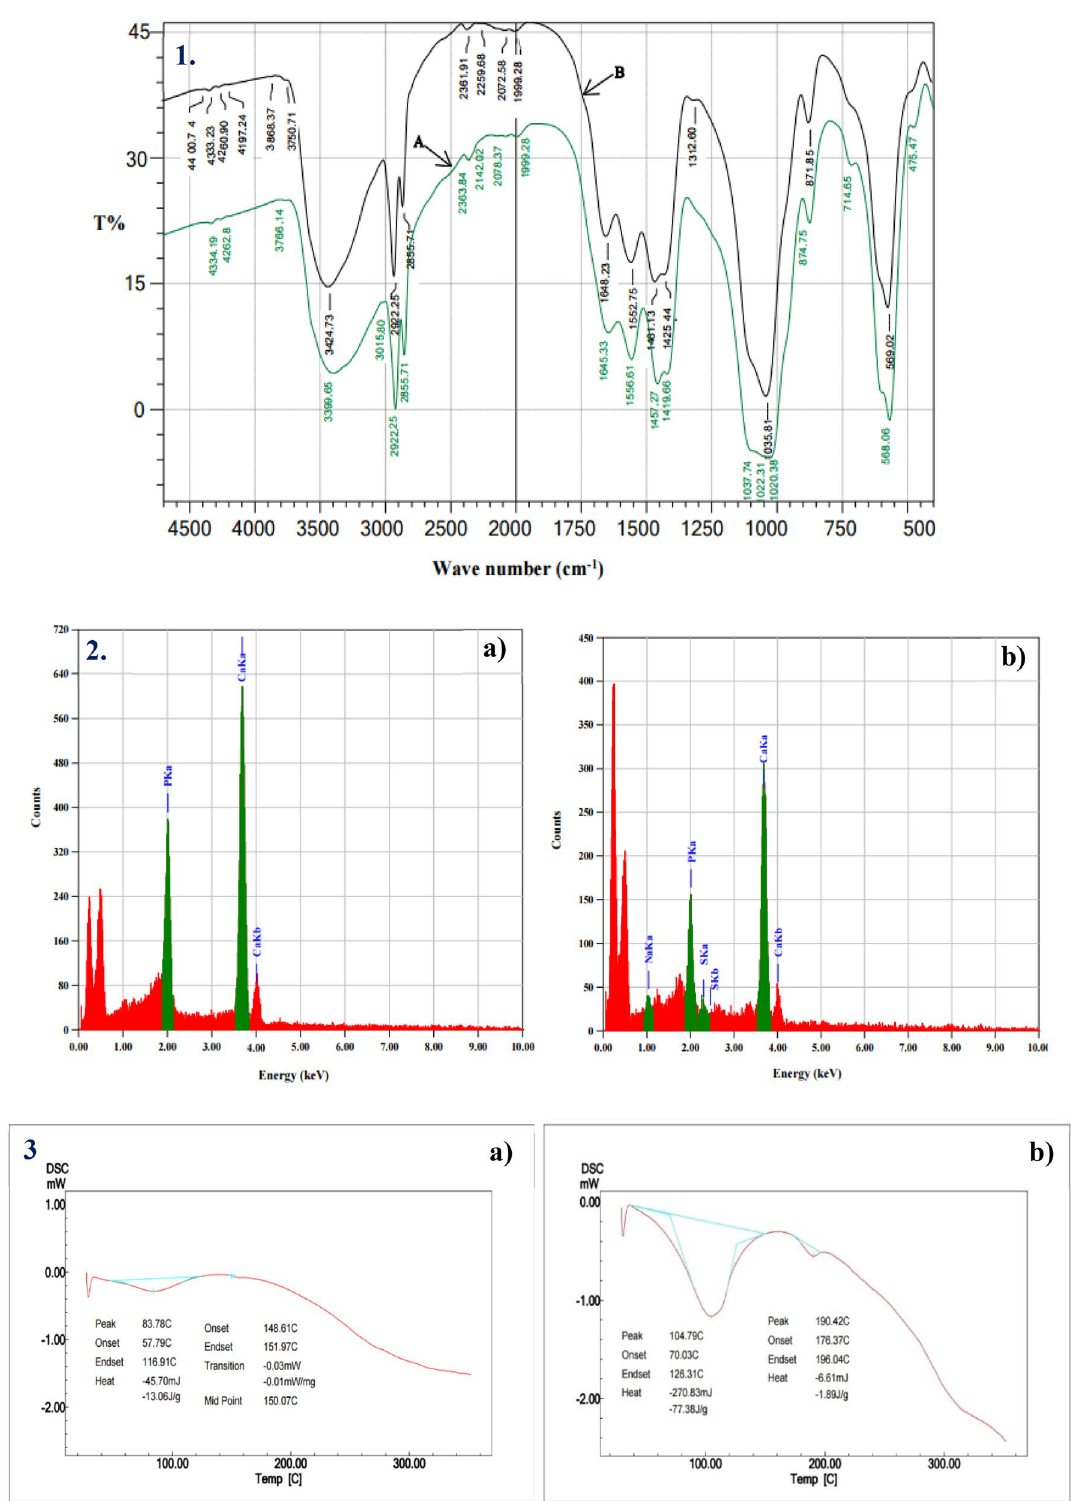
Figure 9. Physicochemical properties of animal bone powder: ( 1 ) FTIR pattern of the (A) untreated (blank) sample and (B) treated sample after fermentation; ( 2 ) EDX analysis of the ( a ) untreated (blank) sample and ( b ) treated sample after fermentation; and ( 3 ) DSC analysis pattern of the ( a ) untreated (blank) sample and ( b ) treated sample after